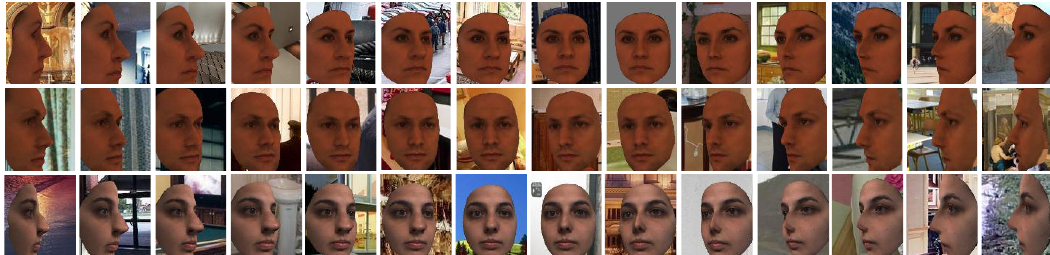
Figure 3. Generated faces on Bosphorus. Fifteen views of each identity are selected from 512 random views that represent multi-view faces ranging from − 90 ◦ to 90 ◦ .